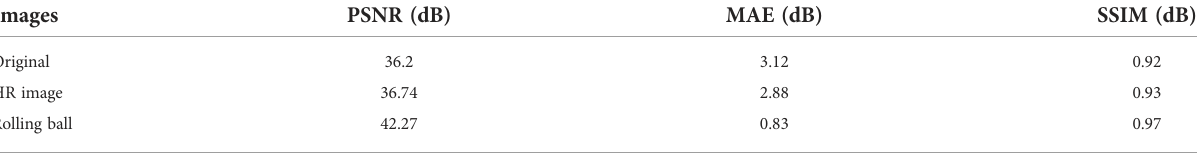
TABLE 1 The values of PSNR, MAE, and SSIM of an image.